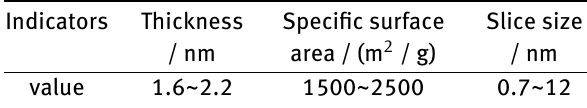
Table 2: Technical indicators of graphene oxide Indicators